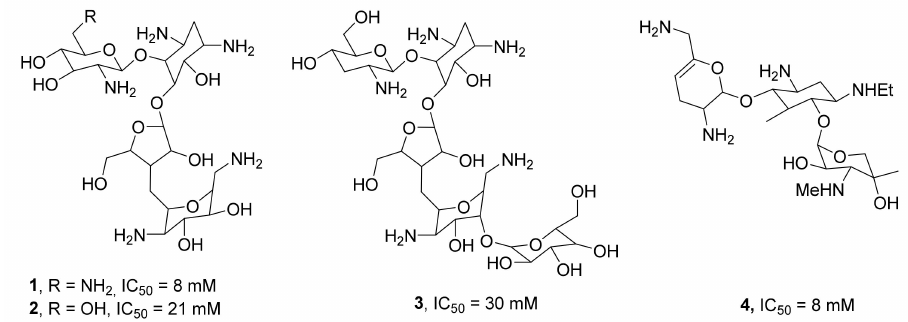
Figure 3. Aminoglycosides as inhibitors of TDP1.